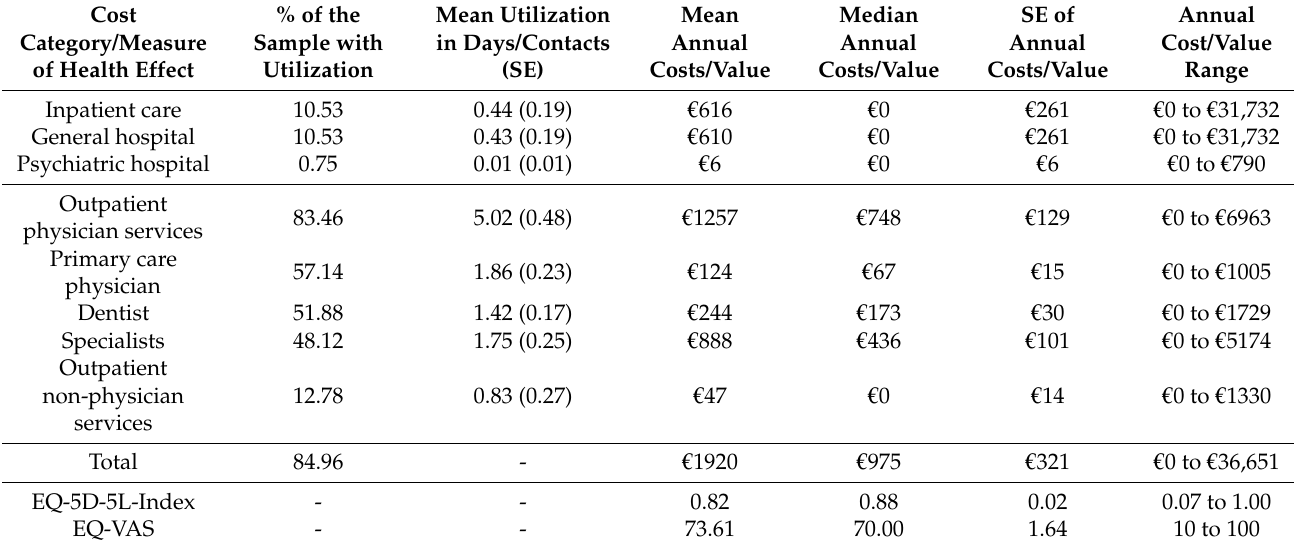
Table 2. The 4-month health care services utilization, annual health care costs and health-related quality of life of refugees with PTSD symptoms ( n =